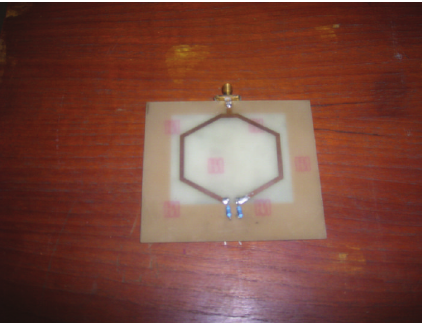
Figure 14: Photo of the HMS antenna with rectangular slot.